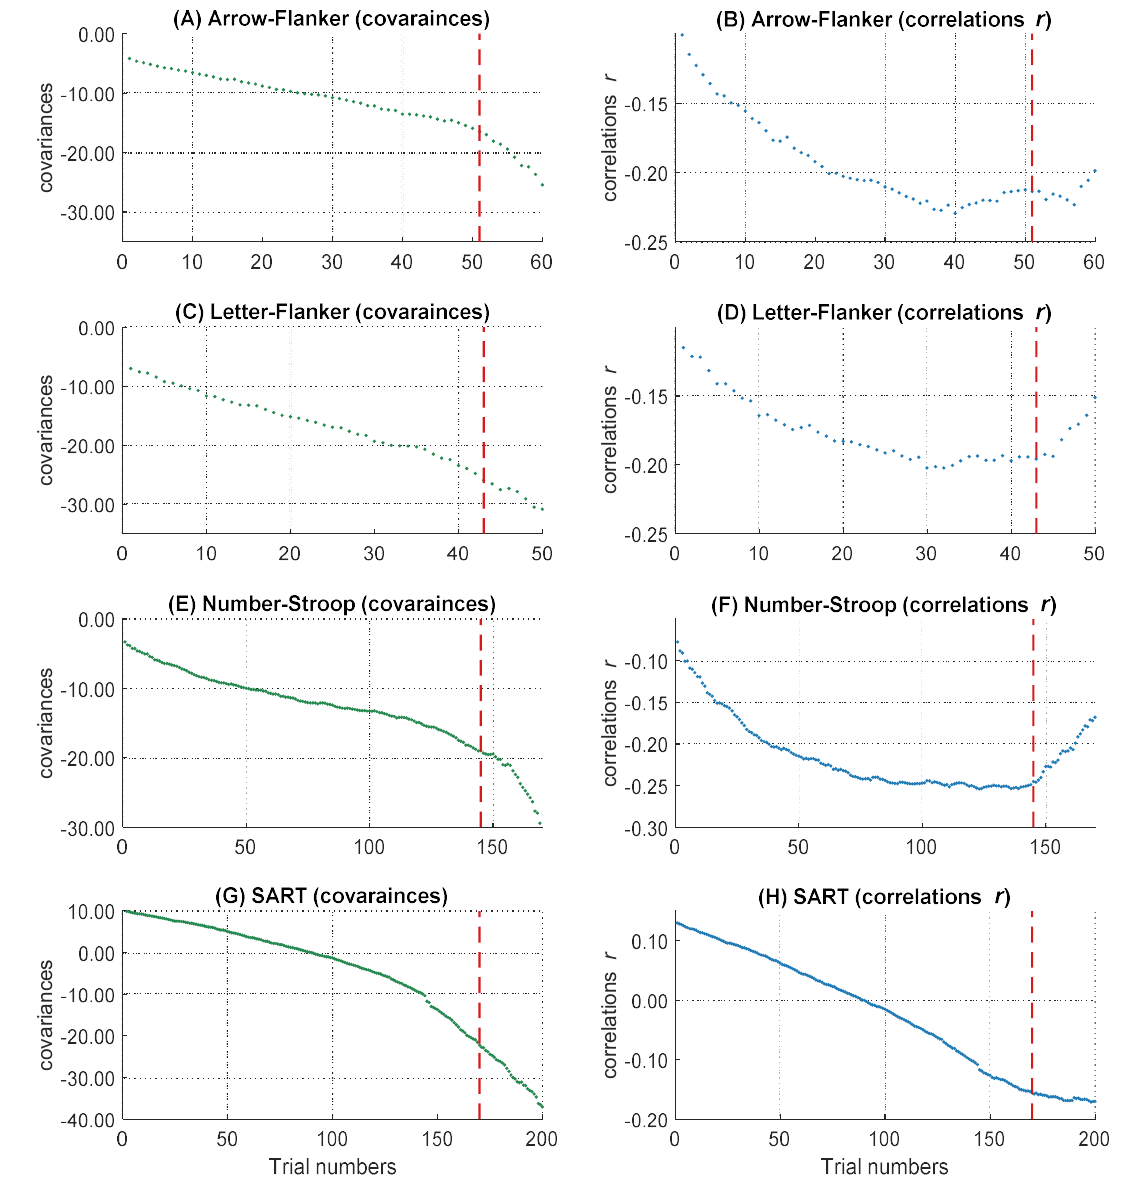
Figure 6. The increasing magnitude of negative correlations and covariances over RT distributions. The courses of the covariances in the four different tasks are shown on the left side ( A , C , E , G ). The courses of the correlations in the four different tasks are shown on the right side ( B , D , F , H ). The dashed lines represent the 85 percent thresholds. Only the left parts of the dashed lines were analyzed in the following multi-level analyses.